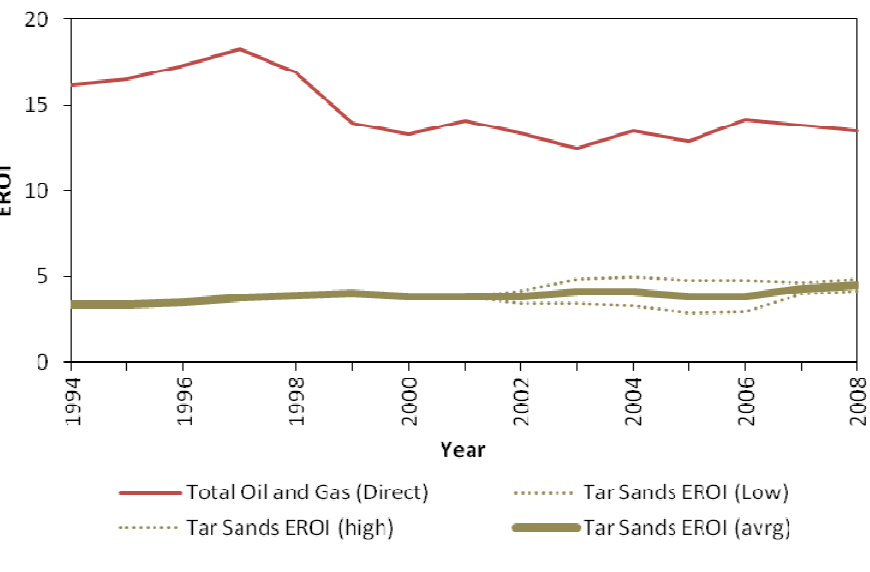
Figure 5. EROI of Canadian tar sands (surface mining, direct energy), from 1994 to 2008. Also shown for comparison, the EROI of total Canadian oil and gas (1994–2008), direct energy.